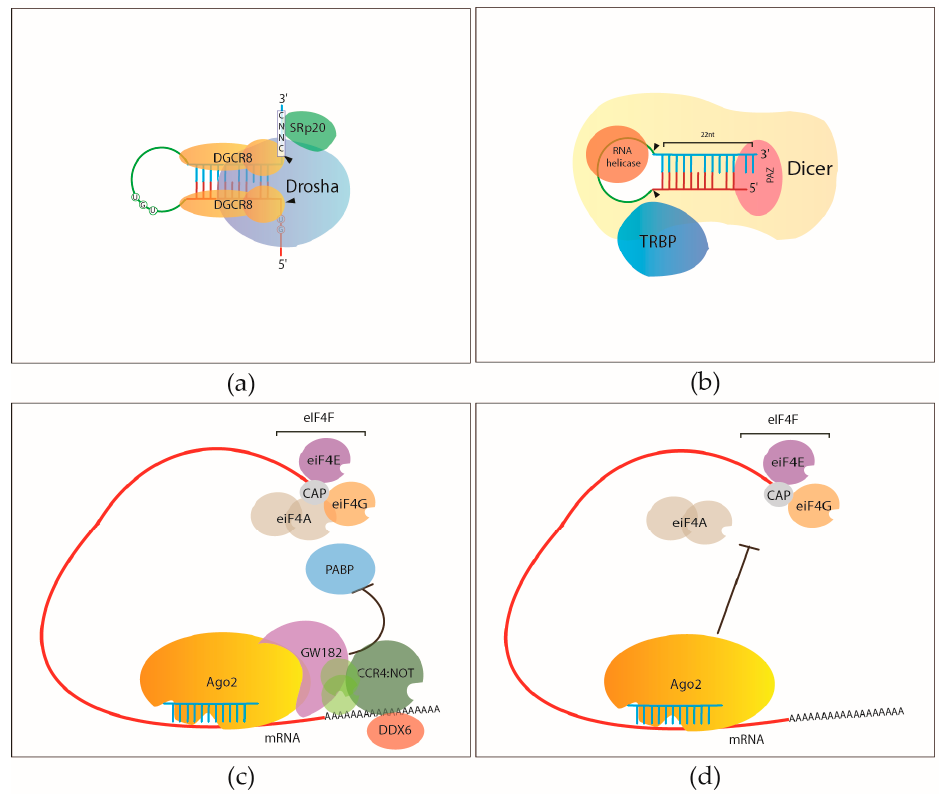
Figure 1. RNA binding proteins of the canonical miRNA biogenesis pathway: ( a ) Sequence motifs and proteins that are required for efficient pri-miRNA processing by the Microprocessor complex; ( b ) Proteins required for pre-miRNA processing; ( c ) Argonaute and GW182 dependent inhibition of translation initiation; and ( d ) miRNA mediated inhibition of translation initiation that is not required GW182.